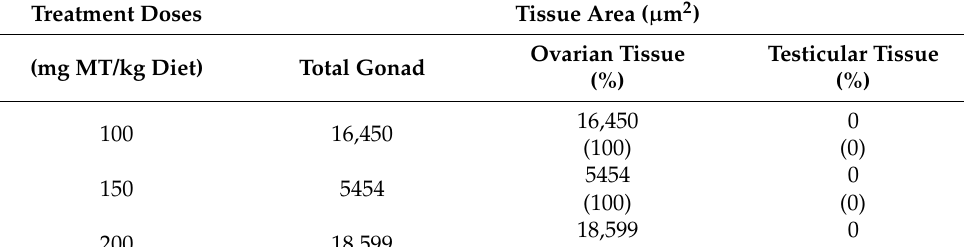
(S2), early (S3) and late (S4) spermatids as well as spermatozoa in spermatozeugmata (SP). Anterior to left and posterior to right.